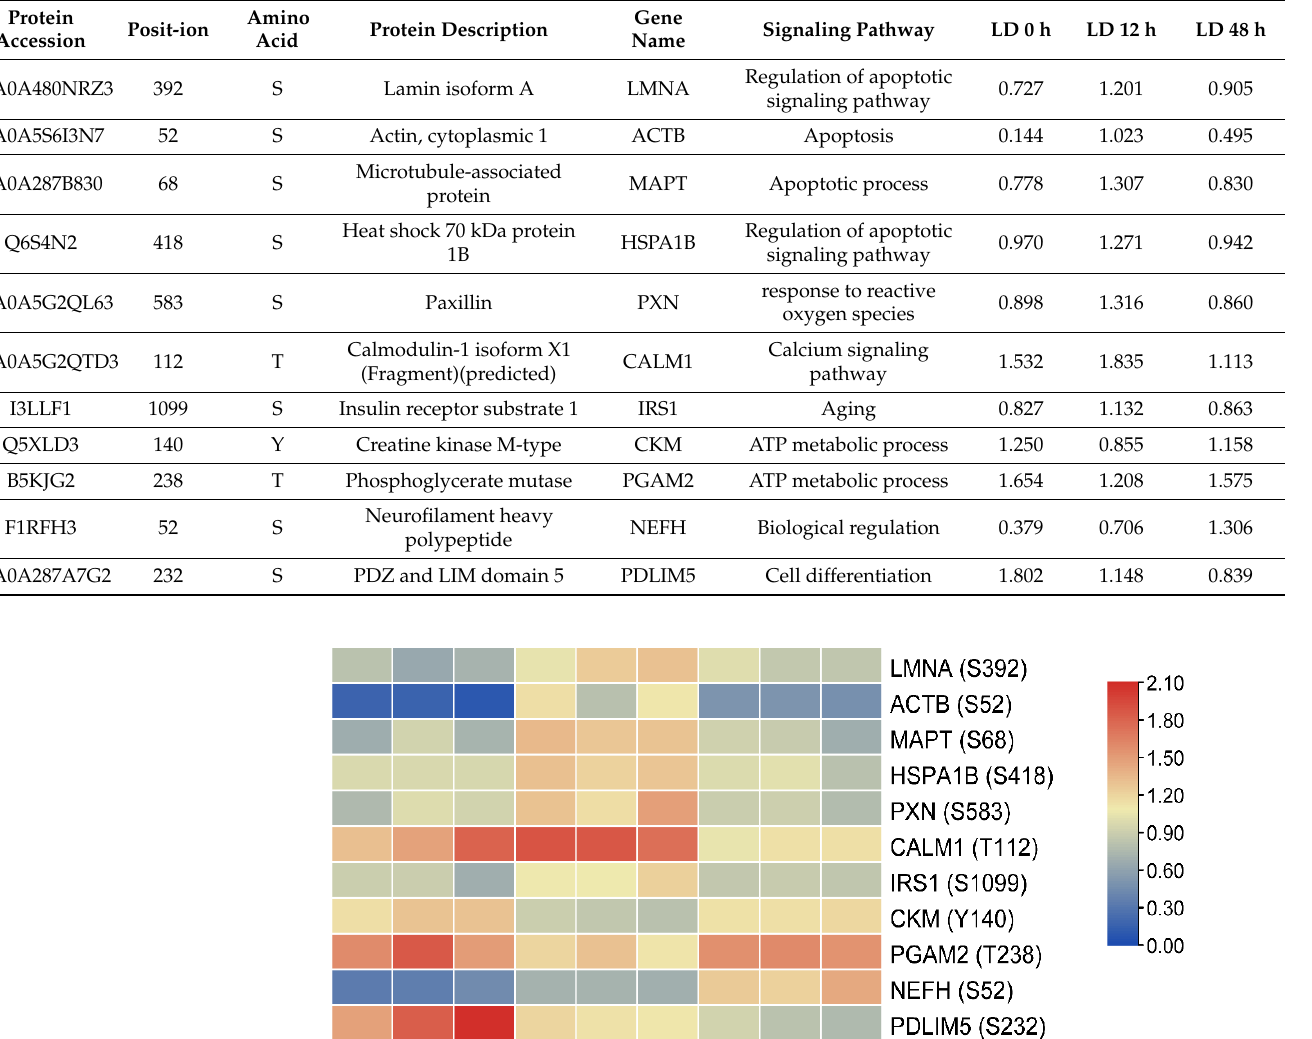
Table 1. Phosphorylation levels of interacting differentially expressed proteins and their involved signaling pathways in postmortem pork muscle.